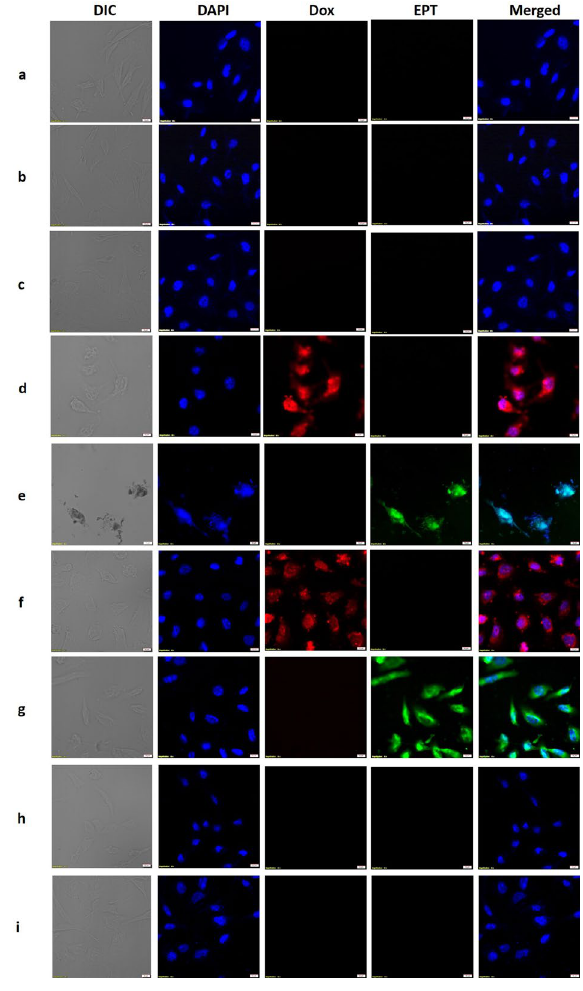
Figure 3. Internalization and distribution of doxorubicin and ellipticine in MDA-MB-231 cells using confocal microscopy. (Panel a ) corresponds to untreated cells; (panel b ) to S268K VLP treated cells; (panel c ) to tLyP-1_ S268K treated cells; (panel d ) to free doxorubicin treated cells; (panel e ) to ellipticine treated cells; (panel f ) to Dox_tLyP-1_S268K treated cells and (panel g ) to EPT_tLyp-1_S268K VLP treated cells. (panel h,i ) show the effect of ammonium chloride treatment of MDA-MB-231 cells on Dox_tLyP-1_S268K and EPT_tLyp-1_S268K VLP internalization respectively. All images are at ×60 magnification.